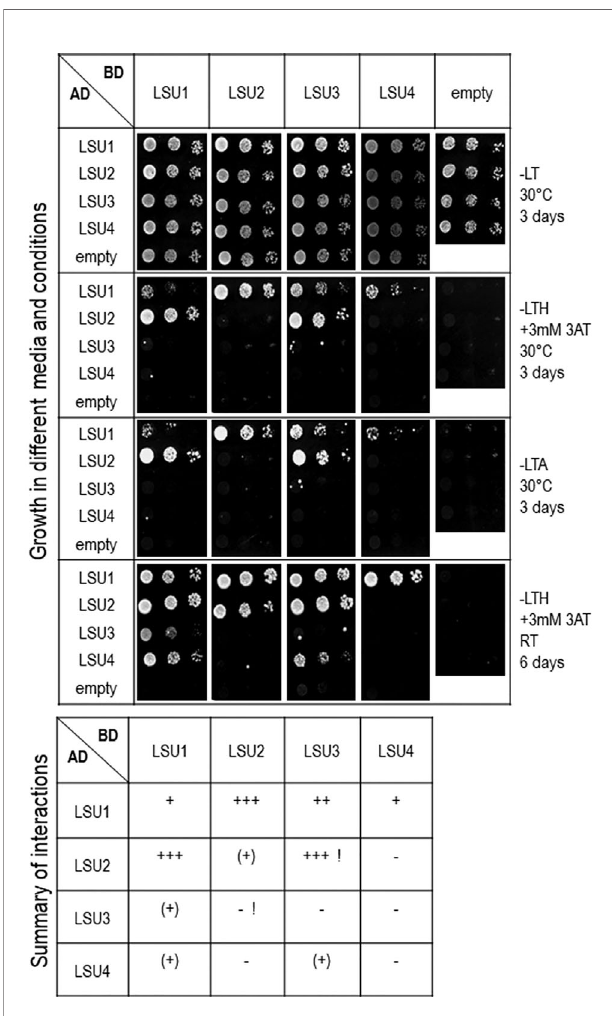
FIGURE 2 | Interactions between LSU – LSU pairs in Y2H experiments. A summary of interactions is shown below the images, illustrating growth of 10- fold serial dilutions of yeast cultures on different selection media. Plates were incubated for three days at 30°C or six days at room temperature (RT), as indicated. The ‘ +++ ’ , ‘ ++ ’ , or ‘ + ’ re fl ects the strength of interaction; (+) refers to growth after only six days. Inconsistent results for LSU2 and LSU3 in two combinations of vectors are marked by exclamation marks